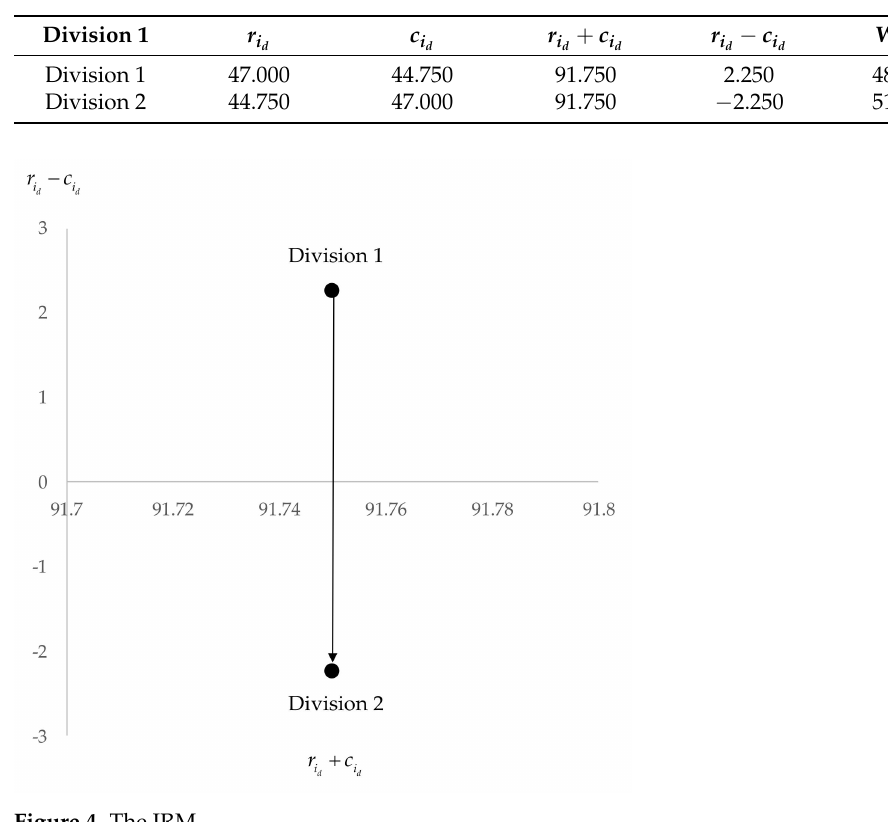
Table 5. Variables for r i